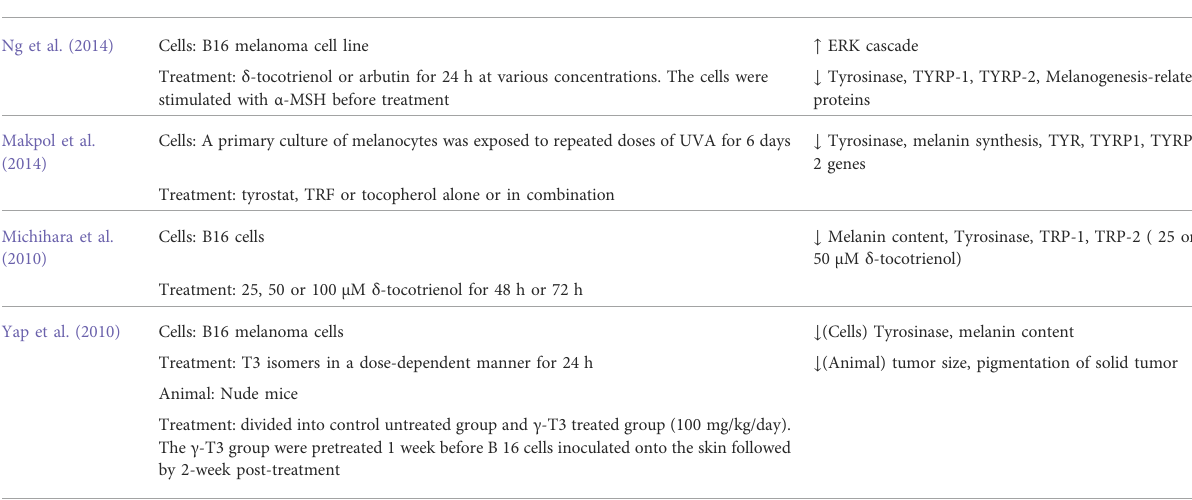
TABLE 3 Effects of tocotrienol and skin pigmentation. Studies Study